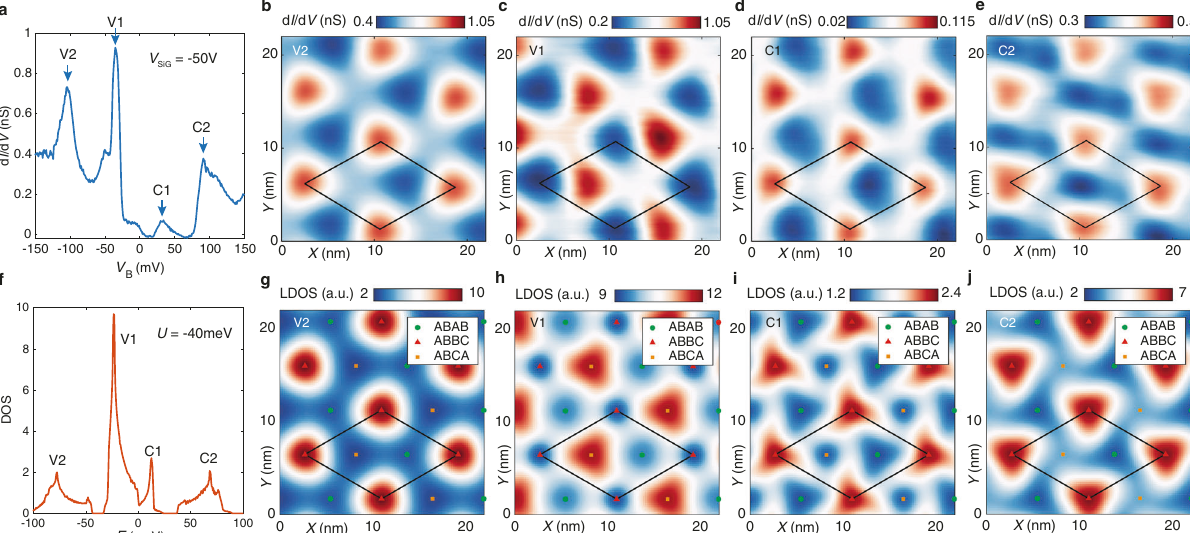
Fig. 2 Visualizing Electronic States of TDBG. a Tunneling spectrum at V SiG = − 50 V and T = 1.4 K, measured with V mod = 5 mV, V set = − 200 mV, I set = 400 pA. f Calculated DOS with parameter U = − 40 meV, which is the onsite potential difference between the top and bottom graphene layer. b – e Conductance maps for V2, V1, C1 and C2 bands, taken at T = 1.4 K, V SiG = − 50 V, V mod = 5 mV. The voltage setpoint of each map is set to the spectrum peaks in a at V set = − 103, − 35, 32, and 91 mV, while the current setpoint is chosen to keep the tip at roughly the same height as a . The plotted data was smoothed with a 0.8 nm radius fi lter. The diamond shapes represent a moiré unit cell. g – j Calculated electron density distribution on the top graphene layer for the four bands. U = − 40 meV is used for this calculation. Shown electron densities are summed over each band (Supplementary Material), which appears to capture the data under these STM setup conditions. The diamonds match with the ones in b – e . Different stacking orders are shown by different colored